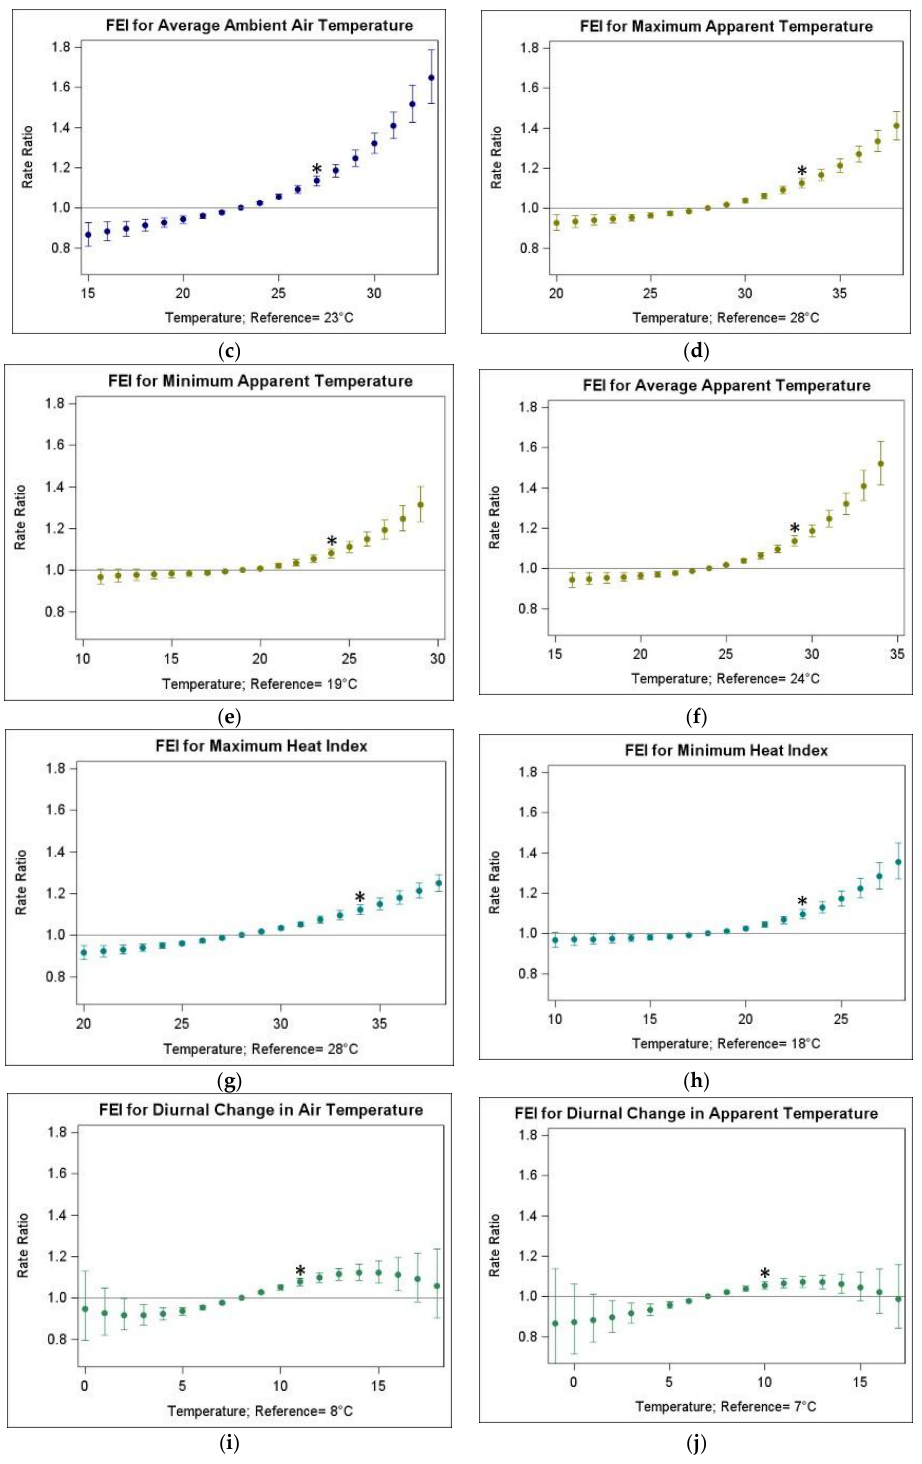
Figure 1. Plots of estimated rate ratios for fluid and electrolyte imbalance ED visits in relation to various temperature increments from the 25th percentile reference for various temperature metrics in Atlanta during warm seasons (May–September), 1993–2012: ( a ) Maximum ambient air temperature; ( b ) Minimum ambient air temperature; ( c ) Average ambient air temperature; ( d ) Maximum apparent temperature; ( e ) Minimum apparent temperature; ( f ) Average apparent temperature; ( g ) Maximum heat index; ( h ) Minimum heat index; ( i ) Diurnal change in air temperature; ( j ) Diurnal change in apparent temperature. * RRs marked by asterisk are equivalent to those reported in Table 3 and represent the RR per IQR from the 25th to 75th